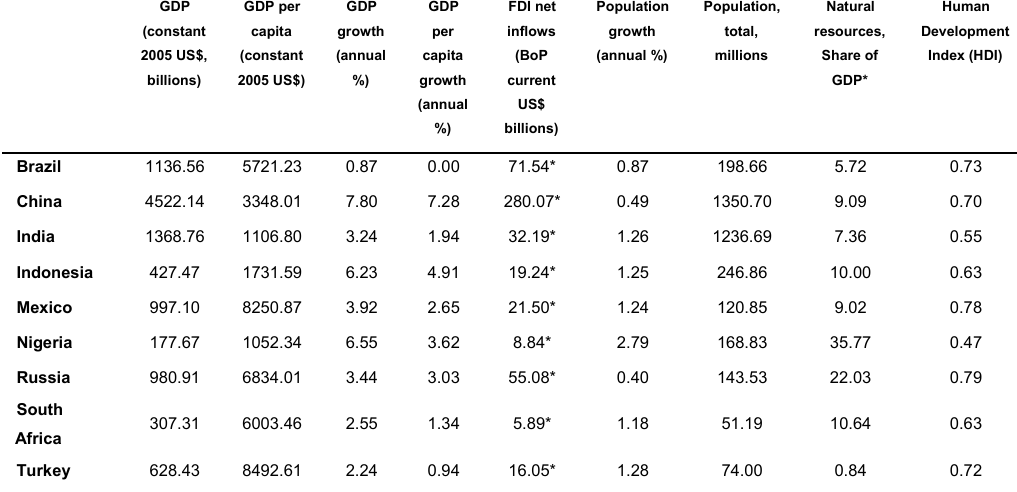
Table 1: Stylized Facts on BRICS and MINT